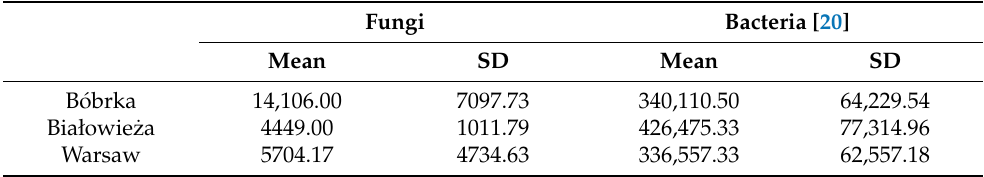
Table 1. Shotgun metagenome analysis was performed on six samples per sampling site (Białowie˙za, B ó brka, and Warsaw). Values presented are expressed as means of classified fungal reads and their standard deviations (SD). Same data are presented for bacteria, which constitute the highest microbial fraction in the phyllosphere.